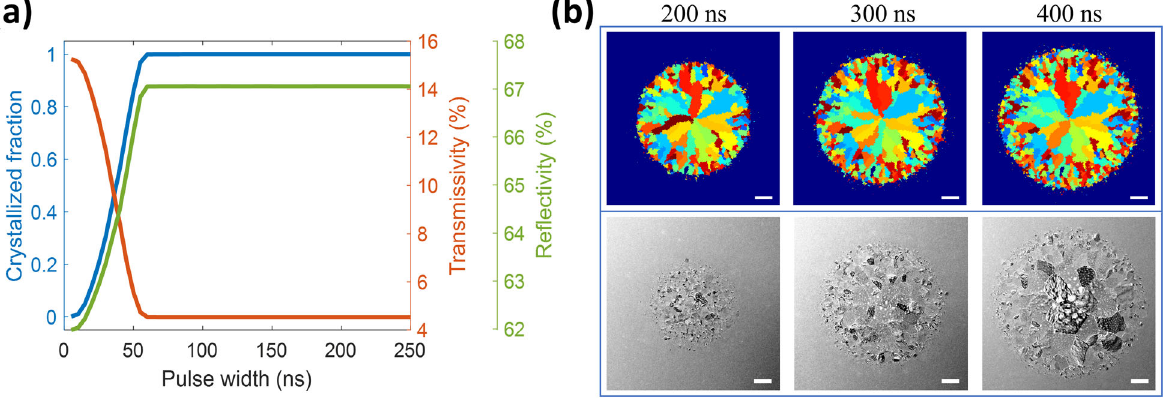
Fig. 5 Partial crystallisatioin by changing pulse width. a The crystal fraction, re fl ectivity, and transmissivity after 5.4 mW laser pulse with different widths. b Corresponding crystallographic microstructures. First row: simulation; Second row: experiments. The scale bar is 200 nm.